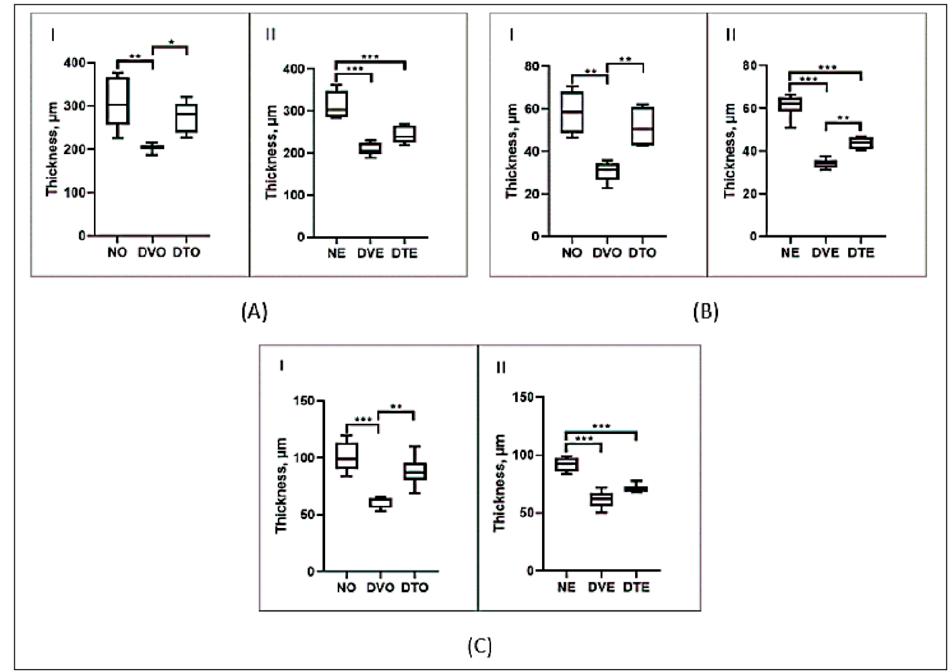
Figure 4. Effect of TRF on the thickness of retina from ( A ) ILM to OLM, ( B ) INL, and ( C ) ONL in rats with STZ-induced diabetes is presented using box and whisker plots. Boxes show median, lower quartile, and upper quartile, whereas whiskers show the data variability outside the upper and lower quartiles. Rats were treated by ( I ) oral and ( II ) topical routes over 12 weeks of the experimental period. NO: Normal rats with oral vehicle treatment, DVO: Diabetic rats with oral vehicle treatment, DTO: Diabetic rats with oral TRF treatment. NE: Normal rats with topical vehicle treatment, DVE: Diabetic rats with topical vehicle treatment, DTE: Diabetic rats with topical TRF treatment. n = 6, * p < 0.05; ** p < 0.01; *** p <